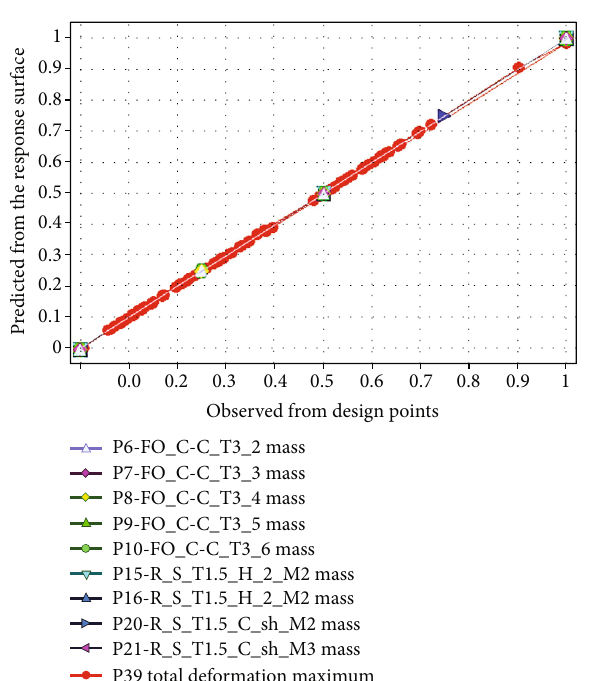
Figure 14: Illustration of the goodness of fi t for the observed and predicted